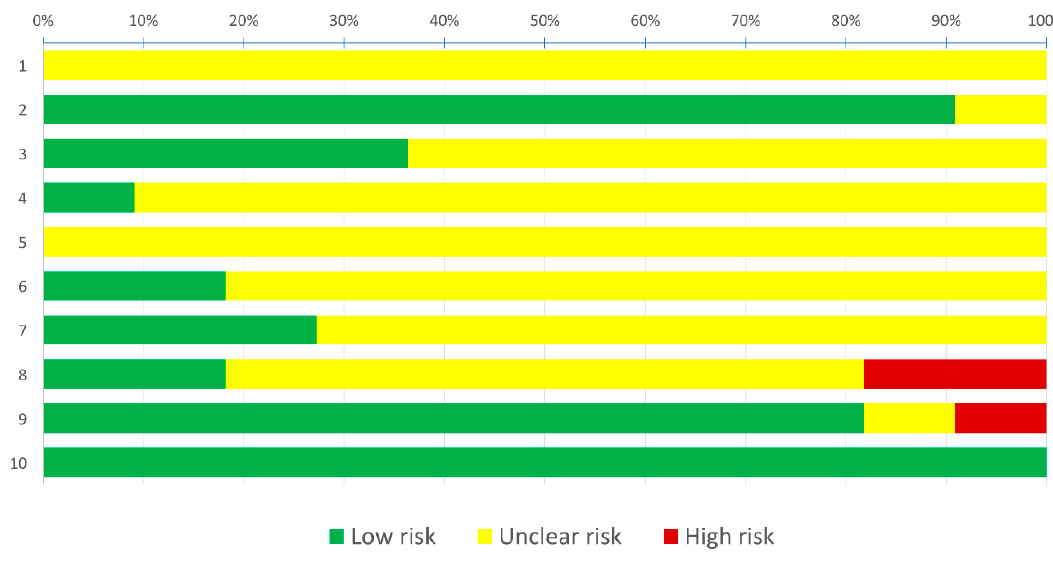
Figure 3. Risk of bias assessment evaluated according to the SYstematic Review Centre for Laboratory Animal Experimentation (SYRCLE): authors’ judgment about each risk of bias item presented as proportions. Selection bias: (1) sequence generation; (2) baseline characteristics; (3) allocation concealment. Performance bias: (4) random housing; (5) blinding. Detection bias: (6) random outcome assessment; (7) blinding. Attrition bias: (8) incomplete outcome data. Reporting bias: (9) selective outcome reporting. Other: (10) consistency of statistical analysis.